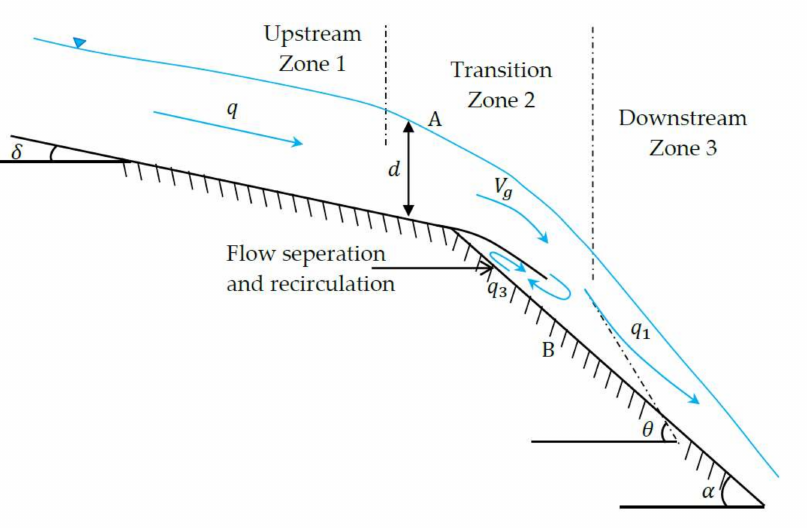
Figure 10. Schematic of a knickpoint flow